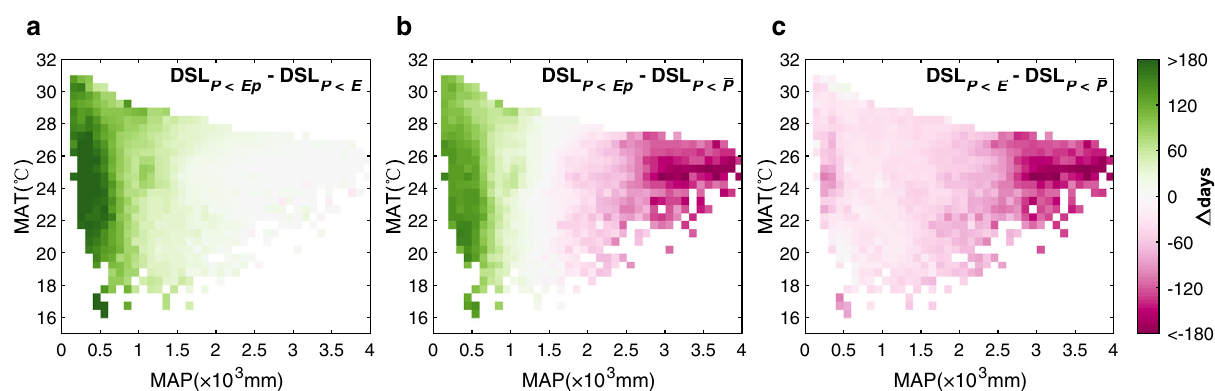
Fig. 3 Inter-metric differences in dry season length by mean annual climate. a – c The differences in dry season length (DSL) were calculated among the three de fi nitions ( P < Ep , P < E , and P < (cid:1) P ), and averaged within each mean annual temperature (MAT) and mean annual precipitation (MAP) interval from ERA-5. Pixel number for each MAT and MAP interval in a – c is shown in Supplementary